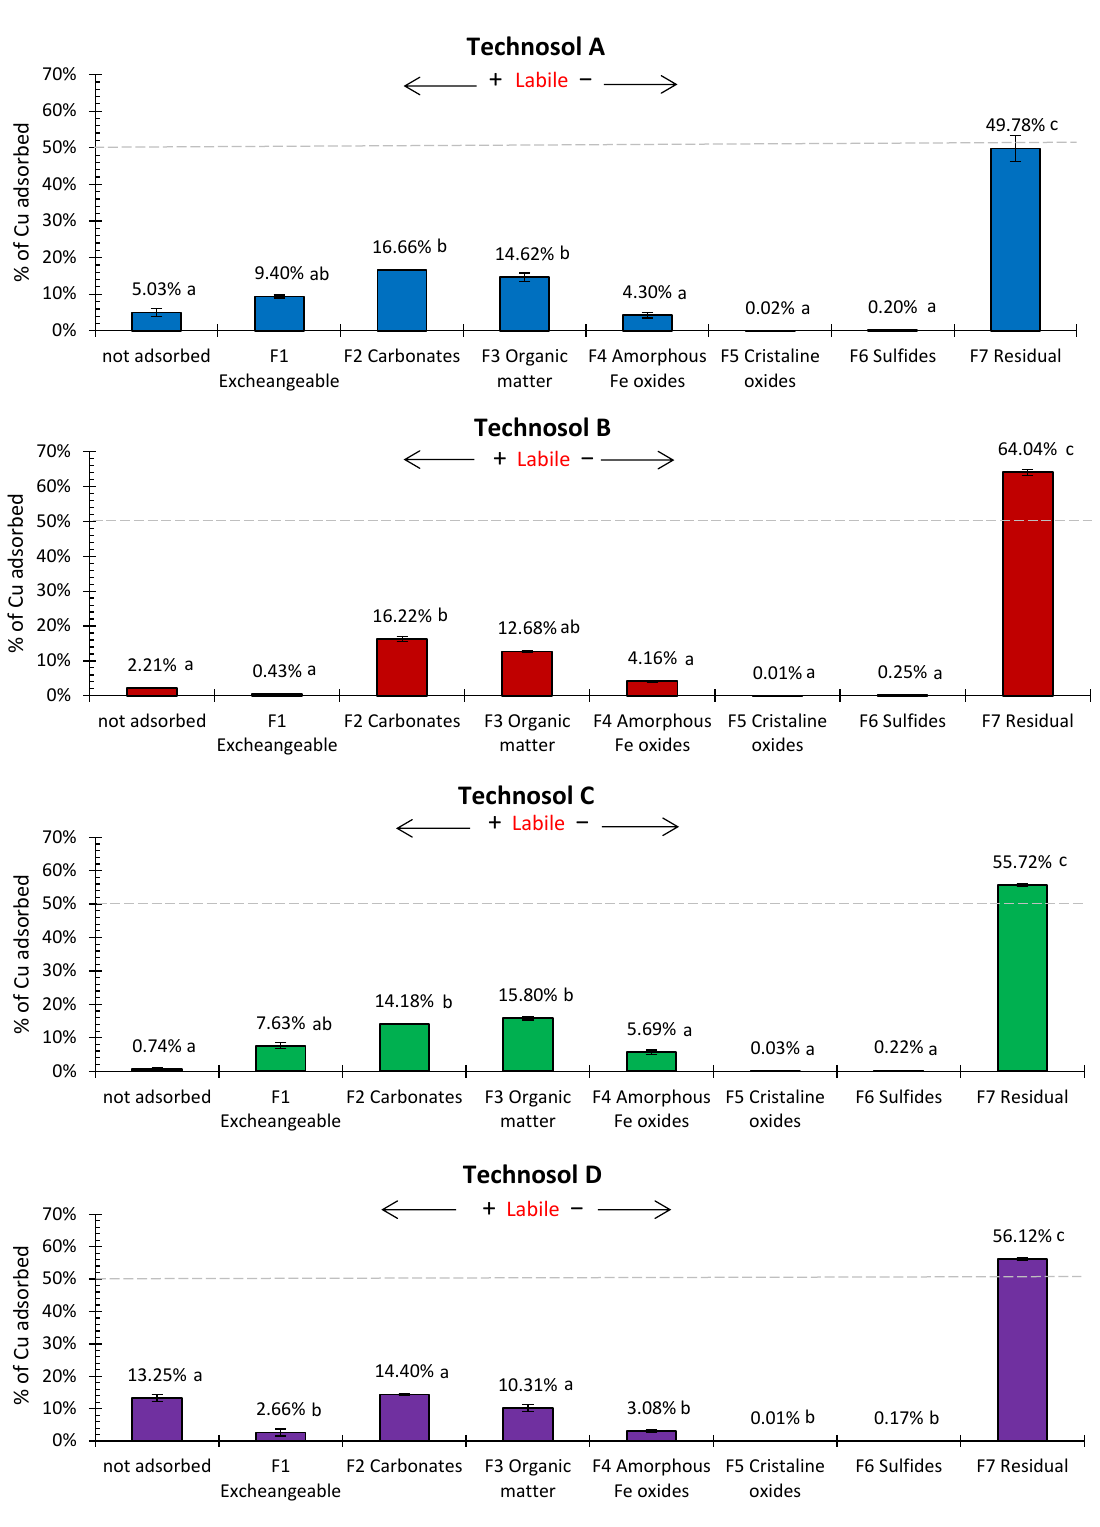
Figure 2. Percentage of copper adsorbed in each Technosol geochemical fraction. The bars from left to right represent from the most labile to the least labile forms of copper. Values indicated by same letters in columns do not differ according to the Tukey test ( p < 0.05) between Technosols ( n = 3). The concentration of Cu that was not adsorbed by the soils (which remained in solu- tion) ranged from 0.74% to 13.25%. The proportion of Cu in the exchangeable fraction (F1) represent a small fraction of the total Cu in the Technosols, ranging from 0.43% to 9.40%.